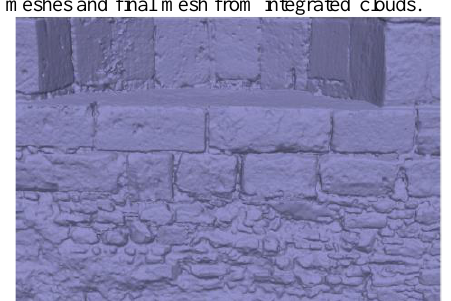
Figure 19. Ability of reading the wall texture in the final mesh surface, derived from LiDAR and UAV